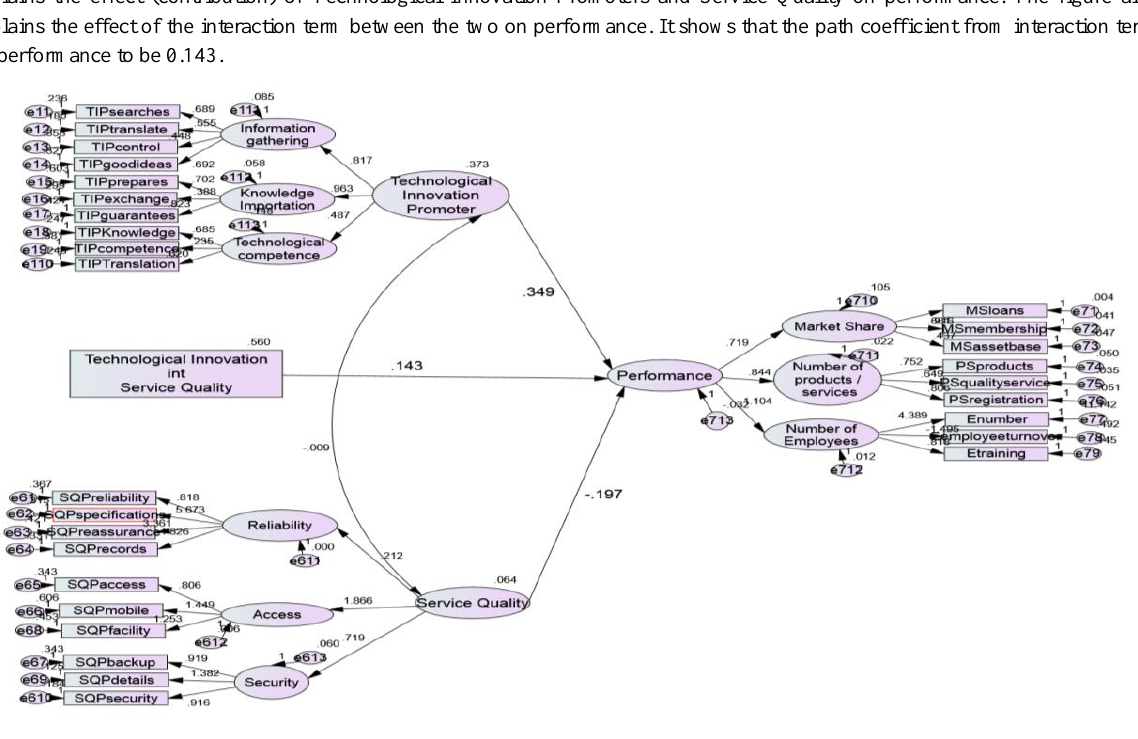
Figure 4: Moderated SEM path diagram for Technological Innovation, Service Quality and